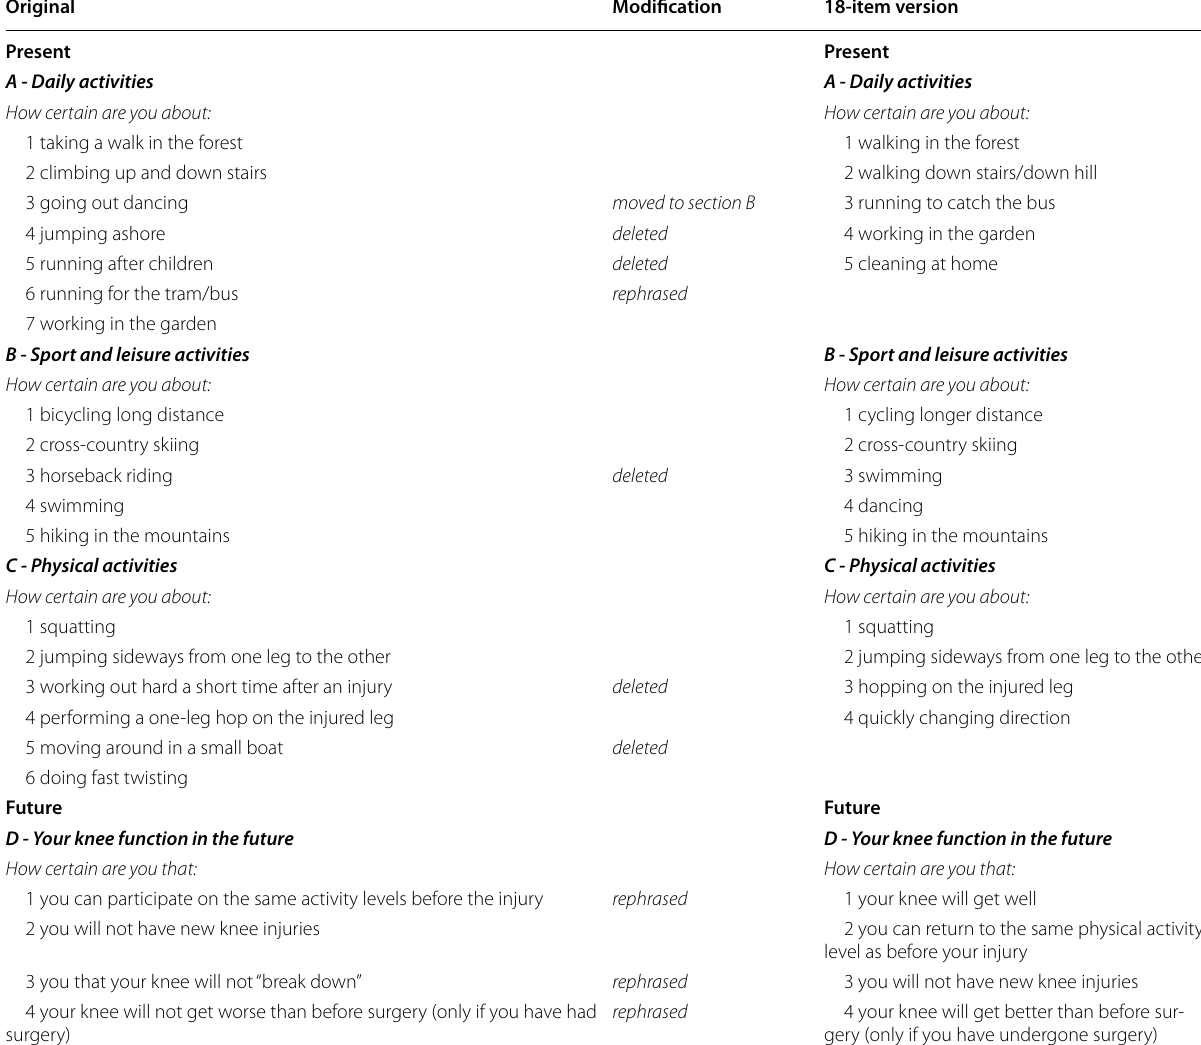
Table 1 The modification of the original version of the Knee Self-Efficacy Scale